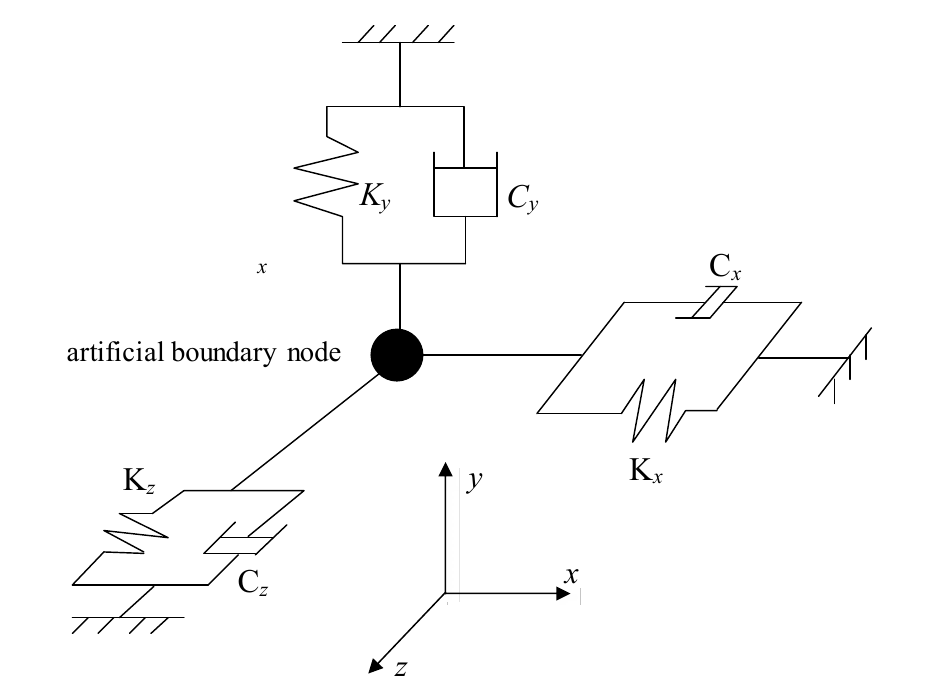
Figure 2. Three-dimensional sketch of the adopted artificial boundary. The parameters of the springs and dampers that constitute the artificial boundary can be obtained by the following equations: in normal direction K N